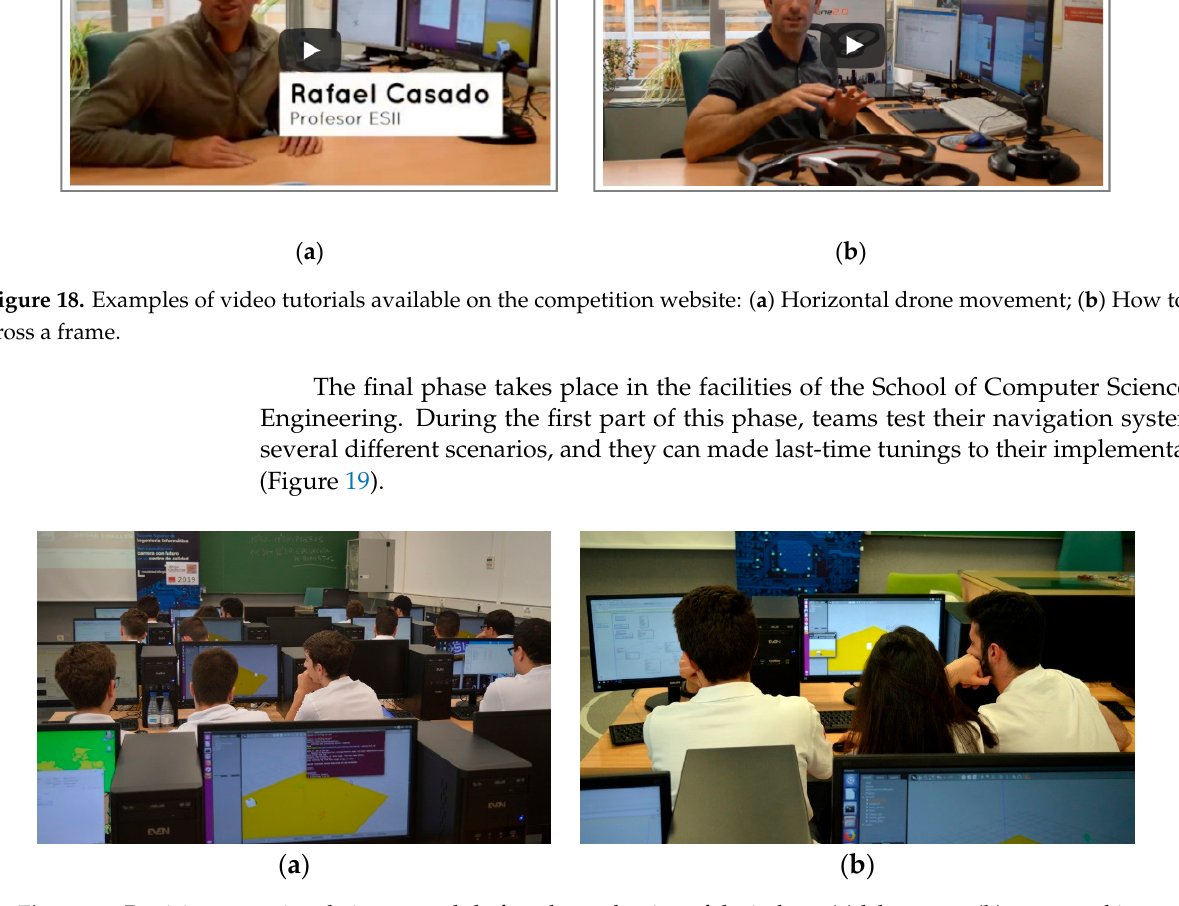
Figure 19. Participants tuning their proposals before the evaluation of the judges: ( a ) laboratory; ( b ) team working.